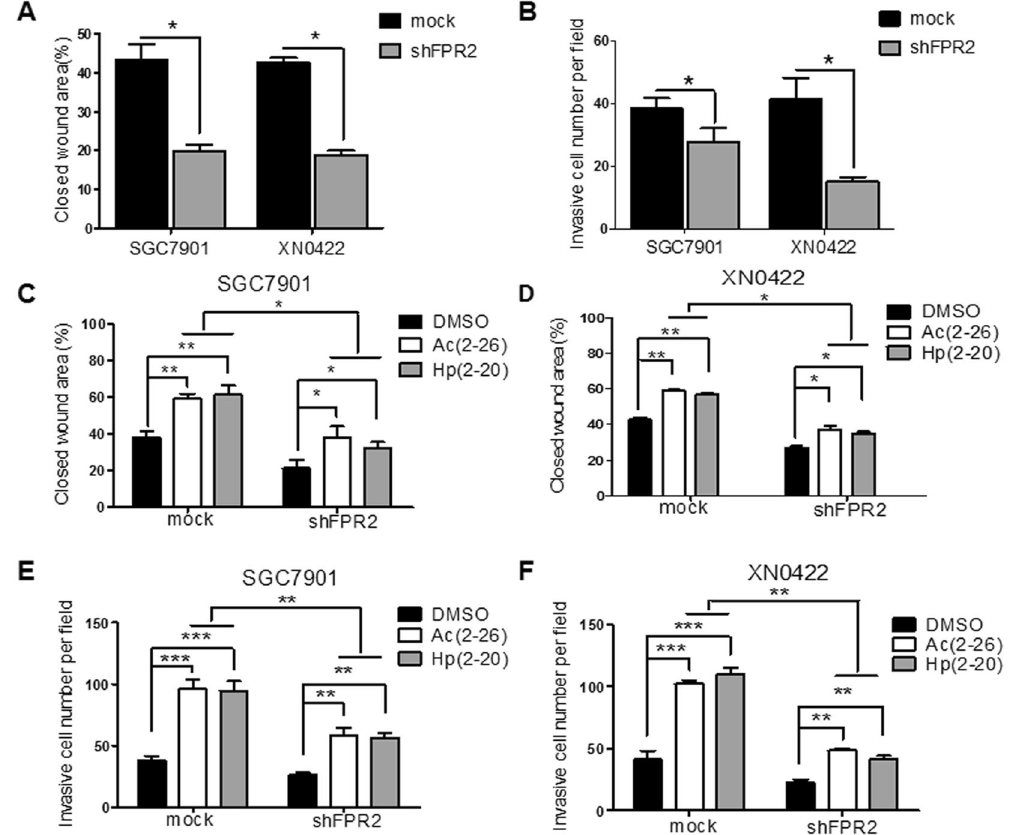
Figure 2. The migratory and invasive capabilities of GC cells are enhanced upon stimulation with FPR2 ligands and attenuated by FPR2-knockdown in vitro . ( A ) Wound healing experiments showed that shFPR2 SGC7901 and shFPR2 XN0422 cells migrate shorter distance than paired mock cells. ( B ) FPR2-knockdown impaired the invasive capabilities of SGC7901 and XN0422 cells. ( C and D ) FPR2 ligands Hp(2–20) and Ac(2–26) enhanced migratory capabilities of GC cells, which was attenuated by FPR2-knockdown. ( E and F ) FPR2 ligands enhanced invasive capabilities of GC cells, which was impaired by FPR2-knockdown. -Data are mean ± SD. * p < 0.05, ** p < 0.01 and *** p <